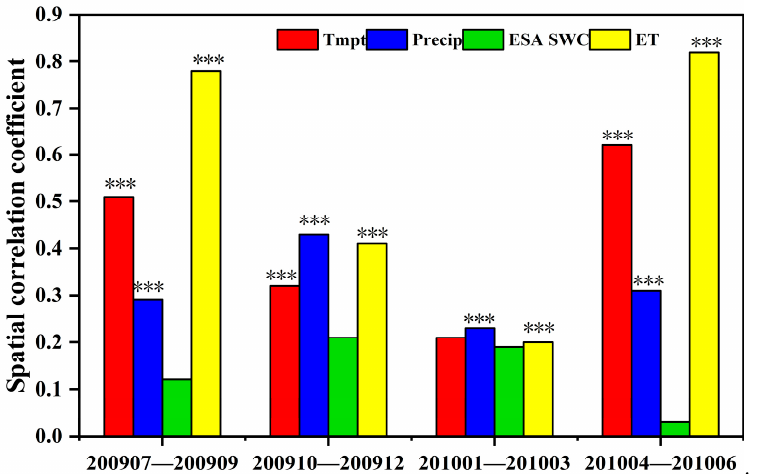
Figure 8. Spatial consistency between SIF anomalies and anomalies of temperature, precipitation, SWC, and evapotranspiration in 2009/2010 (*** indicates p level of 0.05). SWC, and evapotranspiration in 2009/2010 (*** indicates p level of